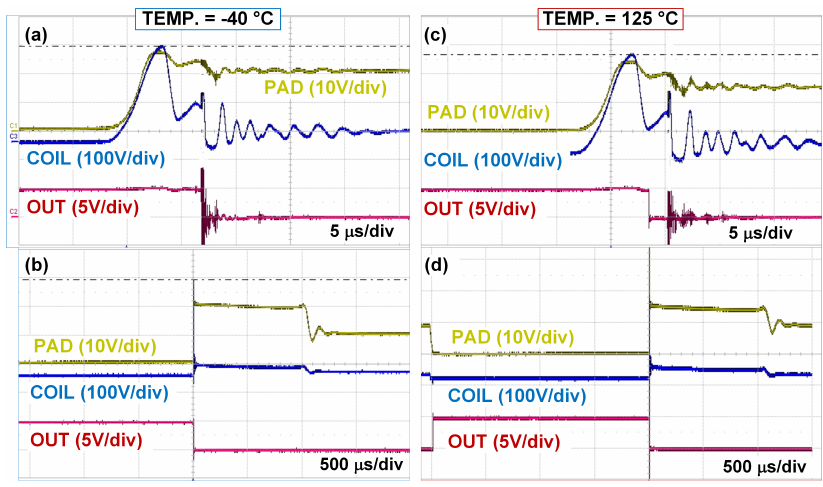
Figure 14. Oscilloscope snapshots of the voltage signals at the igniter coil, chip input, and readout circuit output. ( a , b ) measurements carried out at − 40 ◦ C. ( c , d ) measurements at 125 ◦ C. The plots in Figure 15a show the measured input current of the same interface circuit vs.